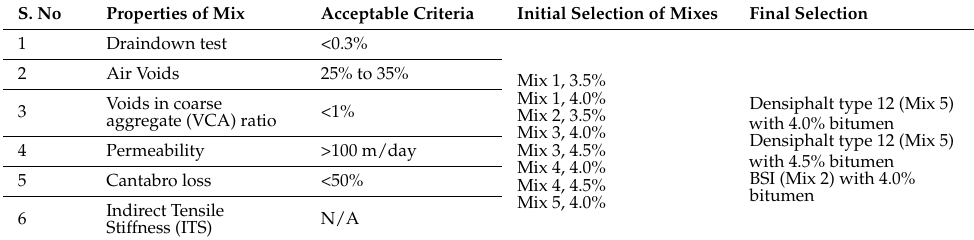
Table 4. Acceptance/rejection criteria for the